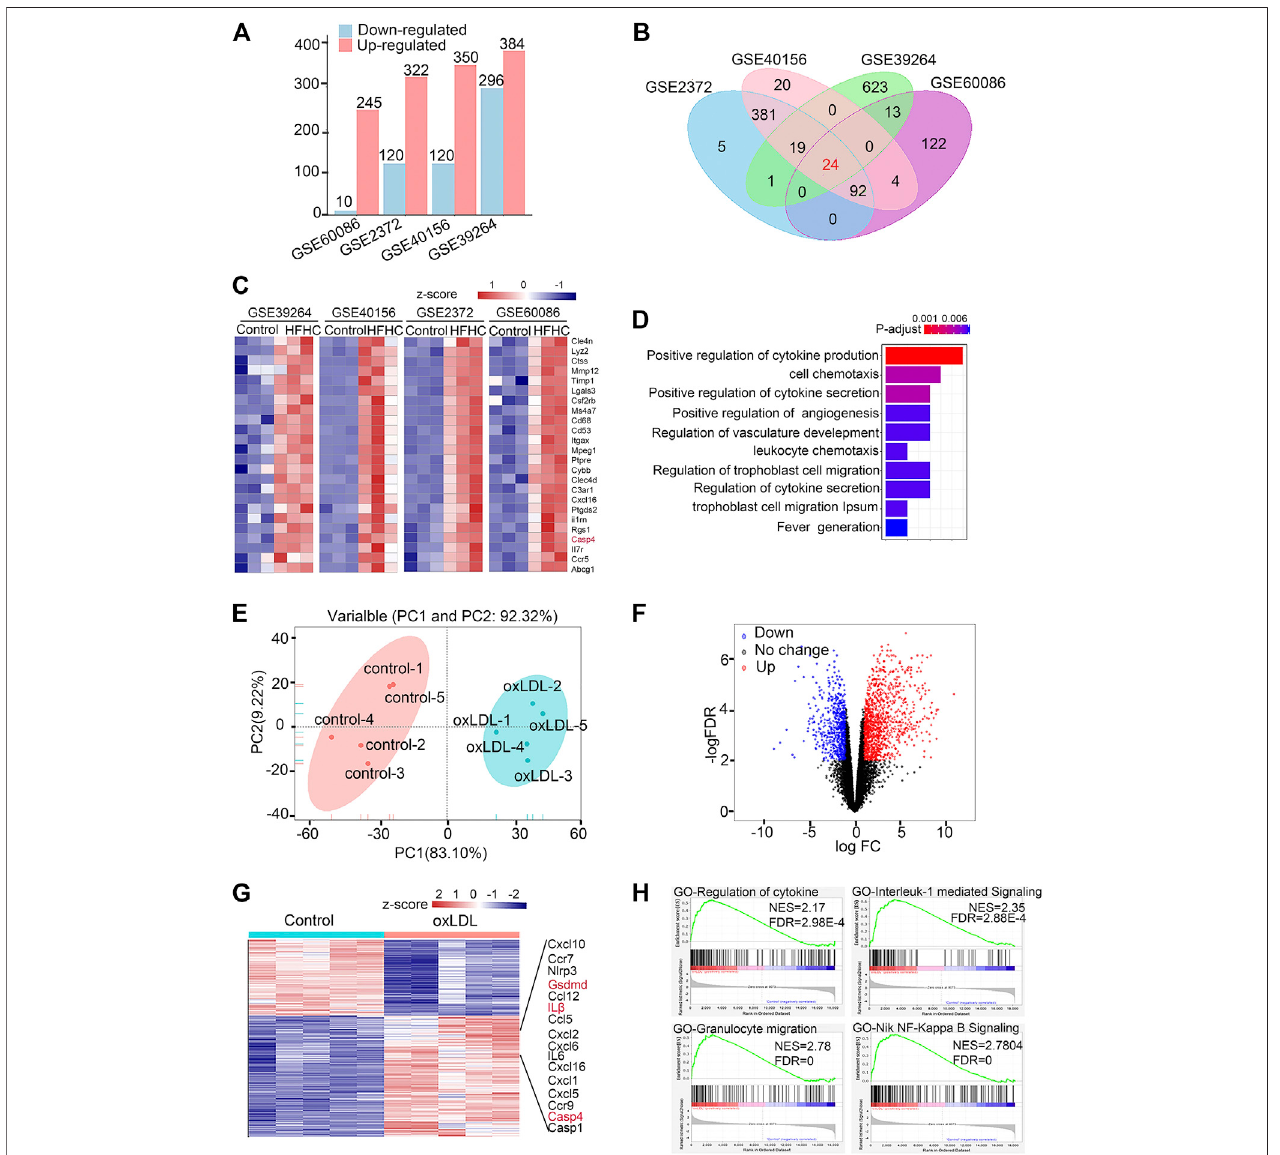
FIGURE 1 | Caspase-11-gasdermin D medicated pyroptosis signaling is involved in the pathogenesis of atherosclerosis. (A) Histogram showing numbers of different expression genes (DEGs) of included datasets in GEO database. DEGs with the cut-off criteria of − log10 False Discovery Rate ( − logFDR) > 2 and |log2 fold change (FC)| > 2 were colored in red for up-regulated gens while in blue for down-regulated genes. (B) Venn diagrams depict 24 genes with consistent pattern of expression across four available transcriptomic datasets from aortic arterial tissue from C57BL/6J or ApoE − / − mice fed with normal chow diet or HFHC in the GEO database. (C) Heatmap of24DEGsin four datasets ofmouse aortas from normal chowdiet or HFHCdiet. Theabscisa represents differentGEOdatasets and samples, and the ordinate represents different genes. The red boxes indicate up-regulated genes, and the blue boxes indicate down-regulated genes. (D) GO term enrichment analysis illustrating number of signi fi cantly up-regulated in the most affected up-regulated genes common in HFHC diet mice aortas compared to the controls. (E) Principal component analysis of bulk RNA-seq data in peritoneal macrophages primed with LPS followed by 16 h of ox-LDL stimulation of control and LDL-treated macrophages. (F) VolcanoplotindicatingtranscriptomicchangesincontrolandLDL-treatedmacrophages.Thereddotsindicateup-regulatedgenes,andthebluedots indicatedown-regulated genes. (G) Heatmap withdifferentially expressed genesincontrolandLDL-treatedmacrophages. DEGswiththecut-offcriteria of − log10False Discovery Rate ( − logFDR) > 2 and |log2 fold change (FC)| > 2 were colored in red for up-regulated gens while in blue for down-regulated genes. The abscisa represents samples, and the ordinate represents different genes. The red boxes indicate up-regulated genes, and the blue boxes indicate down-regulated genes. (H) Gene Set Enrichment Analysis in control and LDL-treated macrophages. GEO, Gene Expression Omnibus; HFHC, high fat high cholesterol; GO term, Gene Ontology term; PCA, Principal component analysis.